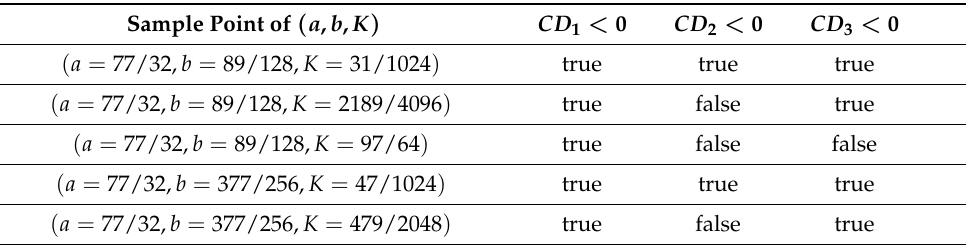
Table 1. Selected Sample Points for { ( a , b , K ) | a > 19/10, b > 0, K > 0 } . Sample Point of ( a , b , K